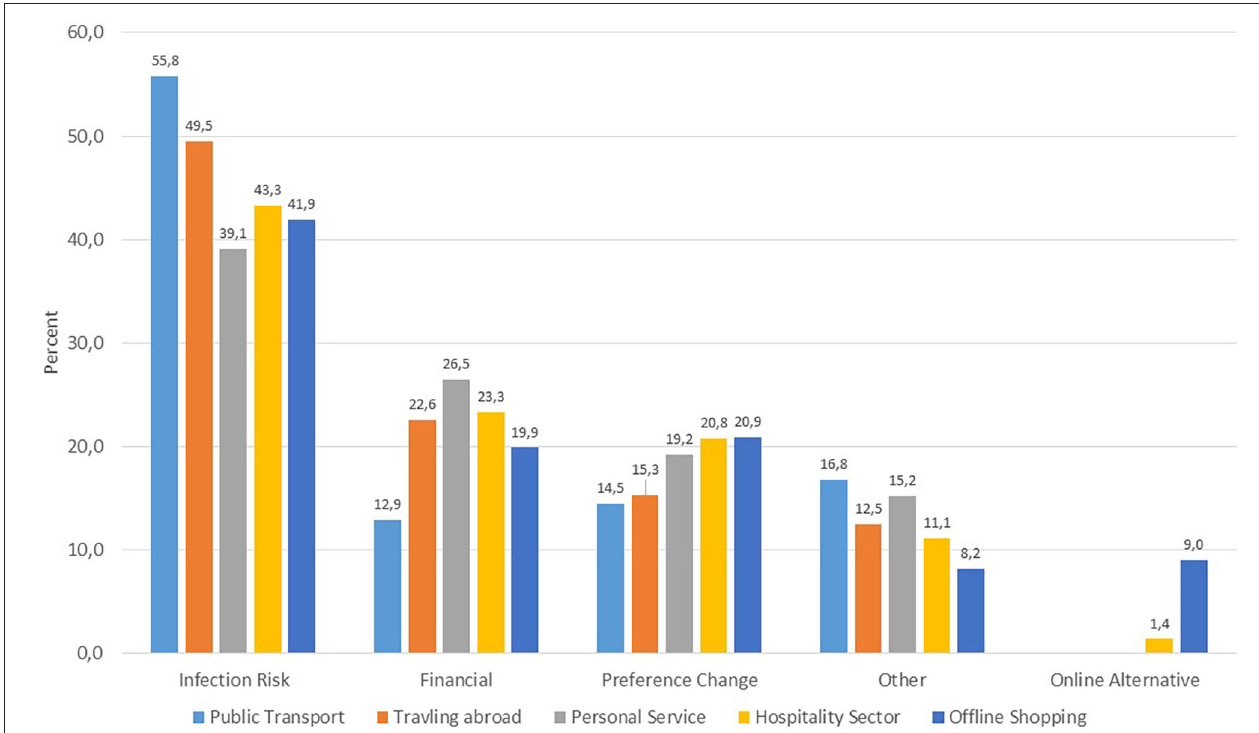
FIGURE 6 | Different reasons for reducing consumption during Corona lockdown in different domains of consumption. Source: own graph, data base: Hodbod et al. (2020).